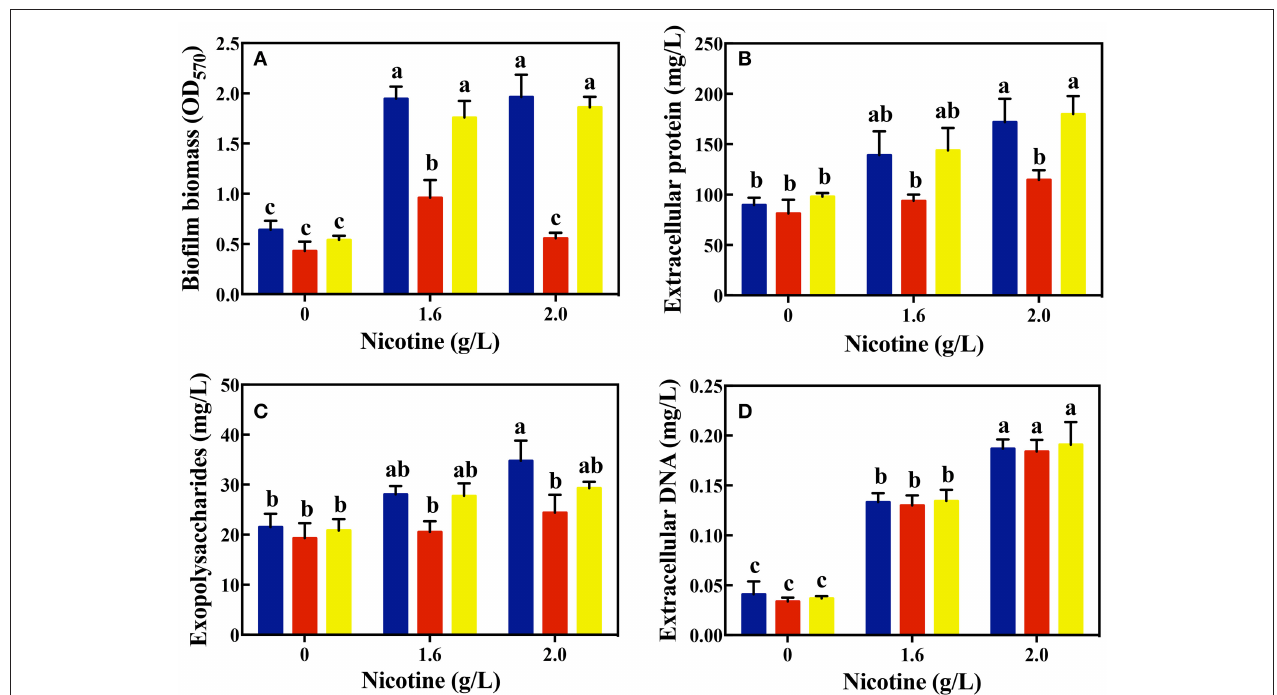
FIGURE 3 | Comparison of biofilm biomass (A) and its components: extracellular protein (B) , polysaccharides (C) , and extracellular DNA (D) among different strains (WT, blue bars; 1 lasR , red bars; 1 rhlR , yellows bars) on exposure to different concentrations of nicotine. Different letters indicate significant difference at p < 0.05 and the same letter indicates no significant difference.